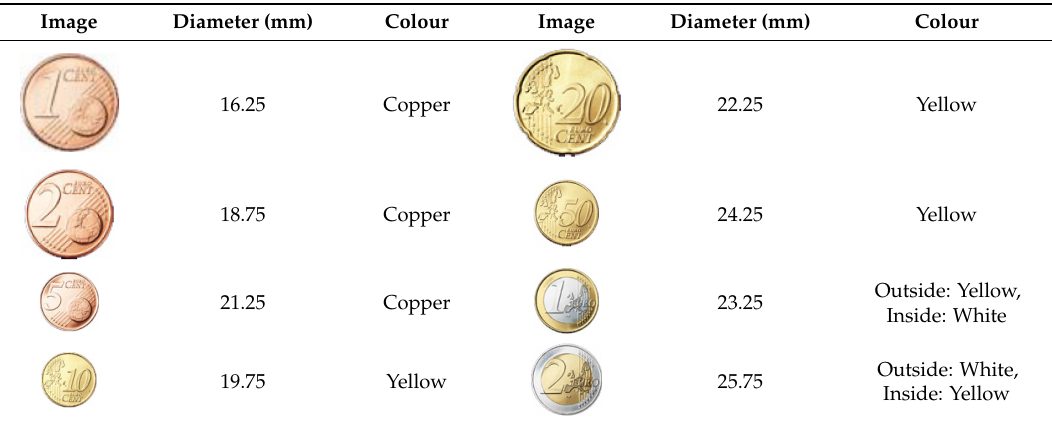
Table 1. Euro characteristics.